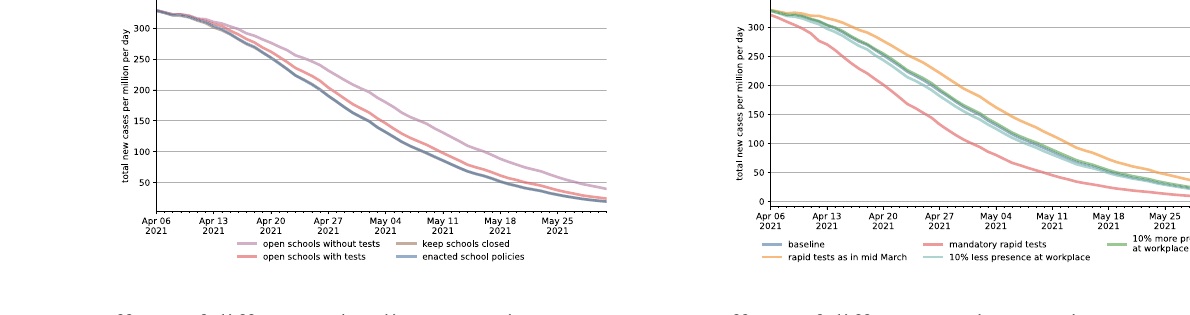
Figure 4. Effects of different scenarios for policies regarding schools and workplaces. Blue lines in both figures refer to our baseline scenario; they are the same as in Fig. 3b. Interventions start at Easter because there were no capacity constraints for rapid tests afterwards. For legibility reasons, all lines are rolling 7-day